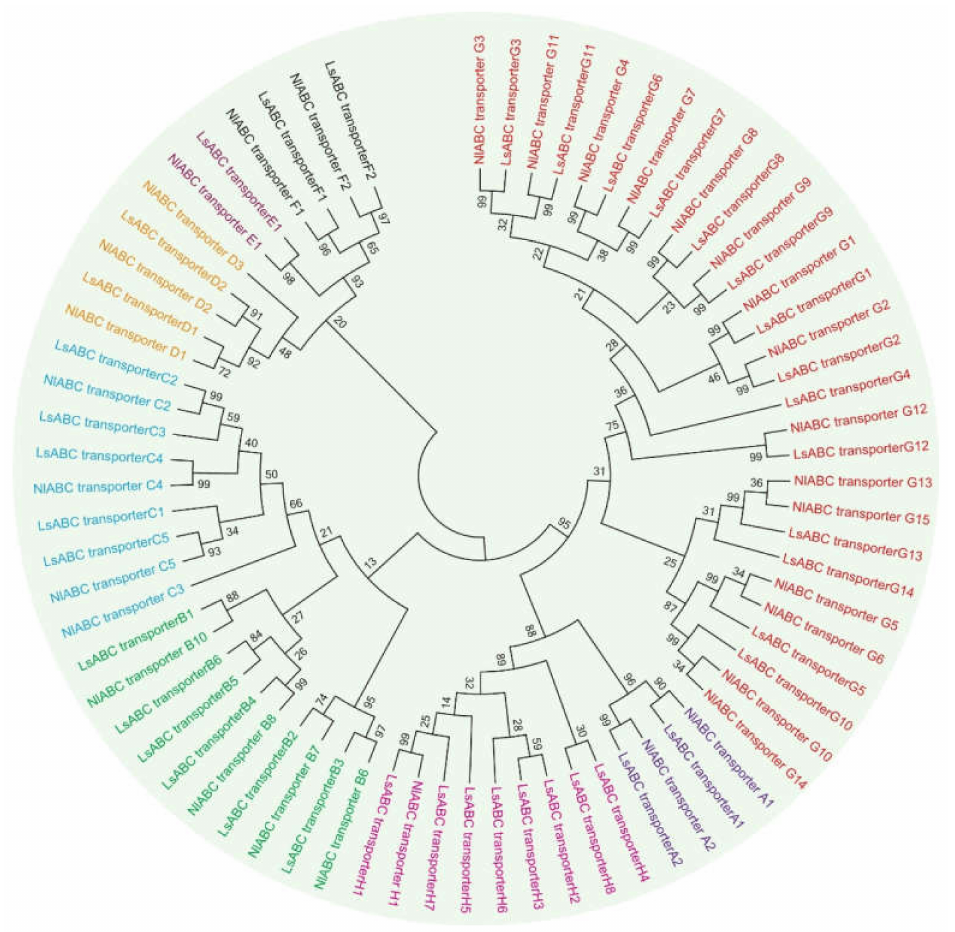
Figure 1. Phylogenetic tree of the Nilaparvata lugens ATP-binding cassette (ABC) transporters. Amino acid sequences of nucleotide-binding domains (NBDs) from N. lugens (Nl) and Laodelphax striatellus (Ls) were aligned using ClustalW and analyzed by the maximum likelihood method in MEGA7 [39]. The bootstrap consensus tree, inferred from 1000 replicates, is taken to represent the evolutionary history of the taxa analyzed. The bootstrap values are shown on the branches. Each color represents one ABC subfamily: